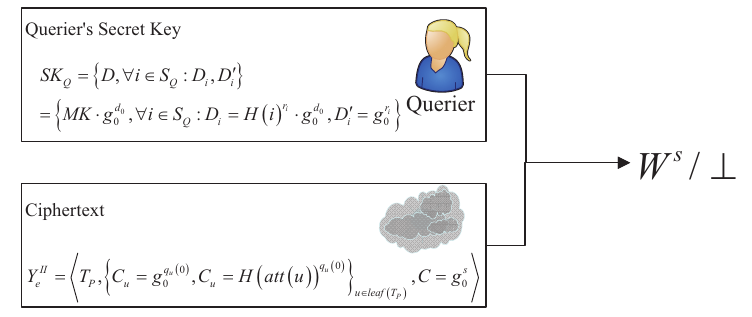
Figure 4. The overview of verification